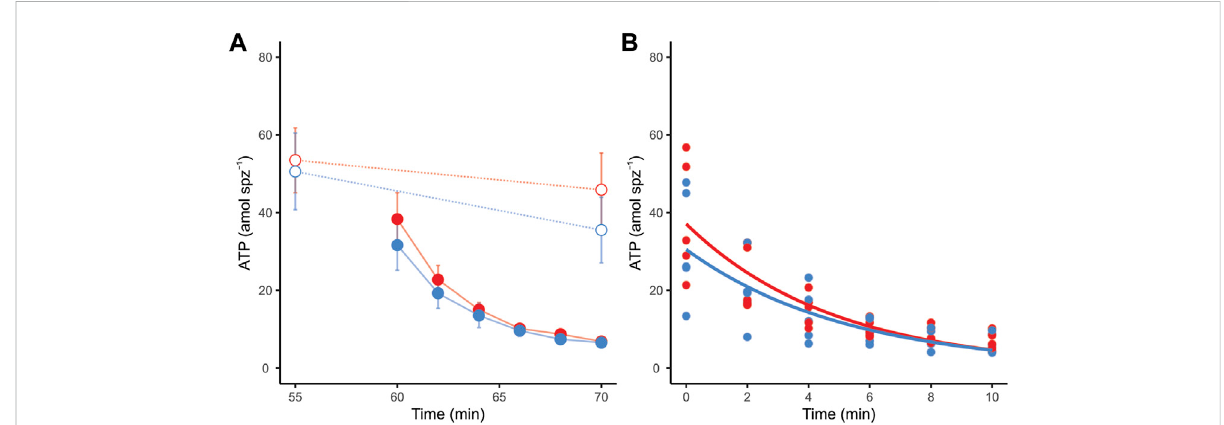
FIGURE 6 ATP consumption in mouse sperm in non-capacitating (red symbols and lines) and capacitating (blue symbols and lines) conditions. (A) ATP content inresponse to theadditionofmetabolicinhibitors to sperm inbothincubation conditions. Dotted linesand opensymbolsrepresent control conditions (no inhibitors added); continuous lines and fi lled symbols represent metabolically inhibited sperm (a combination of 5 µM oligomycin, 50 mM2DOG,1 µMantimycinA,and1 µMrotenonewasadded). (B) LinesrepresentestimatedspermATPconsumptioncurvesofmetabolically